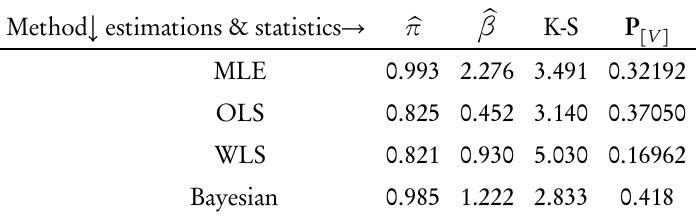
Comparing methods under kidneys